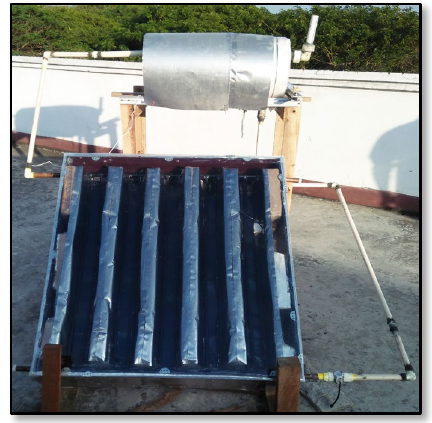
Figure 14. Setup of CPC